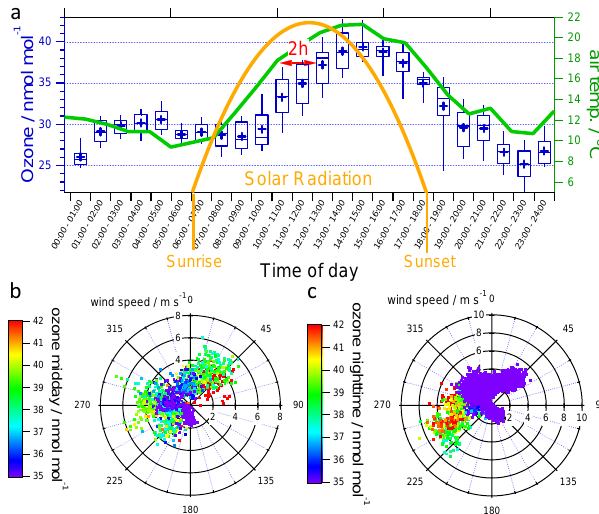
Fig. 10. Summary of the ozone variability at the measurement site. A general characteristic evolution of the daily ozone cycle for “El Arenosillo” using the “Continental” air mass category data is presented in (a) . The temperature was measured using a meteoro- logical station while solar radiation values are just for illustration. While ozone levels follow the solar radiation with a delay of ap- proximately 3h, a delay of 2h was registered relatively to the tem- perature trends. Wind roses (speed and direction) colored by the ozon mixing ratio at early afternoon (12:00–16:00UTC) (b) and at night (21:00–06:00UTC) (c) show that the ozone levels depend not only on the diurnal solar radiation cycle, but also on air mass origin associated with different precursor concentrations and